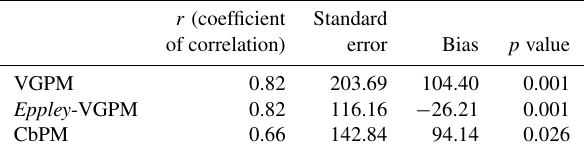
Table 1. Validation of ocean-color-based models (VGPM, Eppley - VGPM, and CbPM) with in situ net primary production (mgCm − 2 d − 1 ) estimated using 13 C tracer during the scientific ex- peditions to the Southern Ocean in 2009. CbPM: carbon-based pro- ductivity model; VGPM: vertically generalized production model. r (coefficient Standard of correlation) error Bias p value VGPM 0.82 203.69 104.40 0.001 Eppley -VGPM 0.82 116.16 − 26 . 21 0.001 CbPM 0.66 142.84 94.14